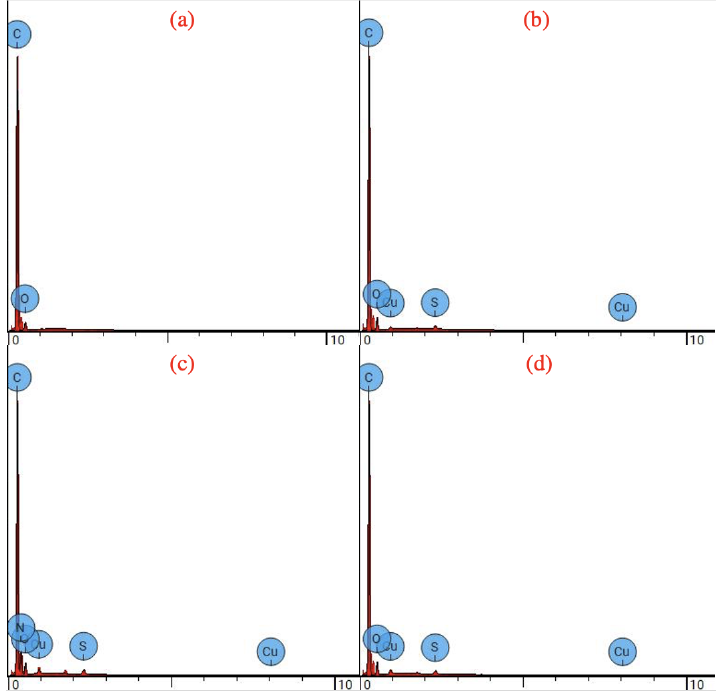
Figure 5. ( a ) EDX Spectrum of Pure PAN Nanofibers ( b ) EDX Spectrum of 5% PAN-CuNP Nanofibers ( c ) EDX Spectrum of 10% PAN-CuNP Nanofibers ( d ) EDX Spectrum of 15% PAN-CuNP